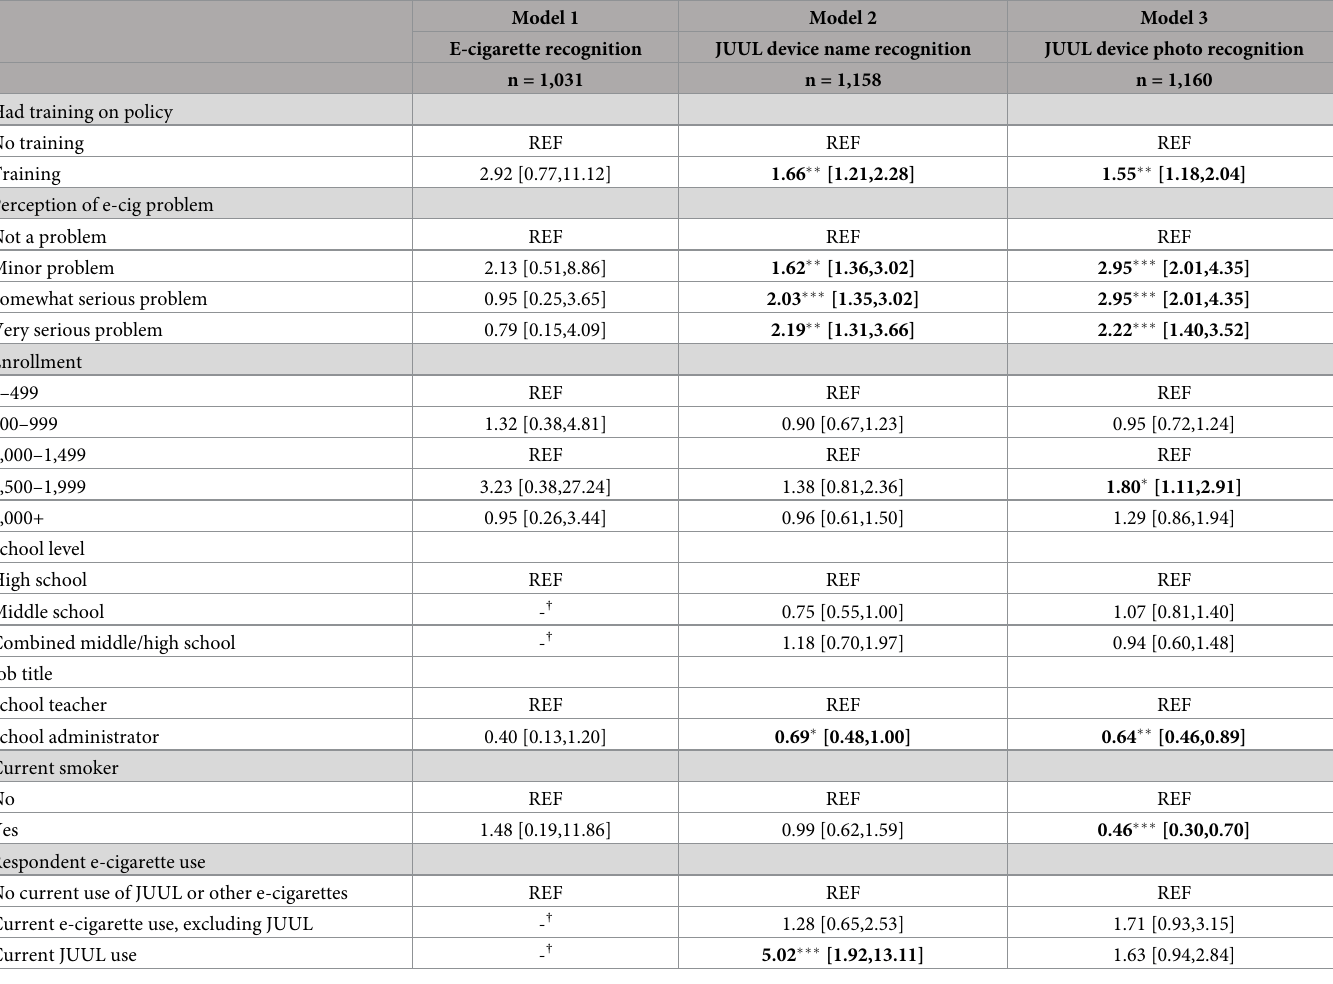
Table 4. Predictors of e-cigarette/JUUL recognition among school personnel working in a school with an e-cigarette/JUUL